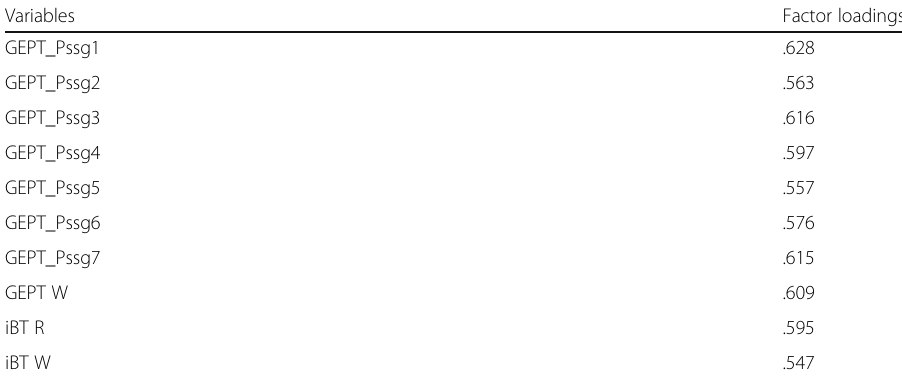
Table 8 EFA results for GEPT-A and iBT reading and writing scores